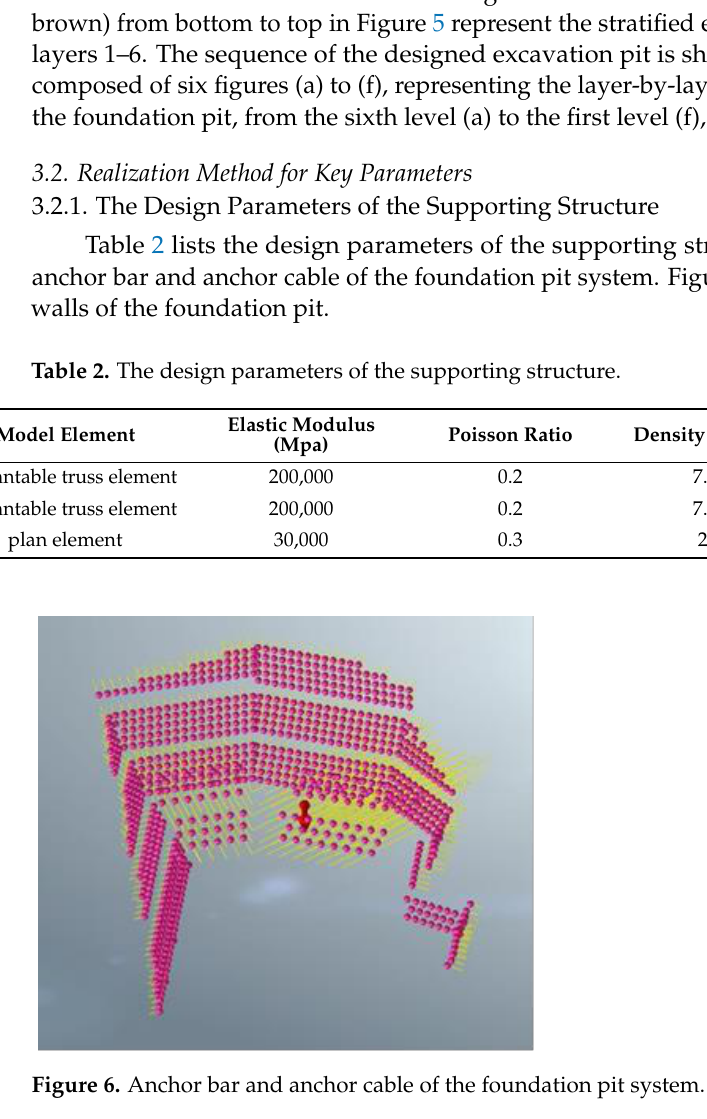
Figure 7. Retaining walls of the foundation pit. Table 2. The design parameters of the supporting structure. Material Type